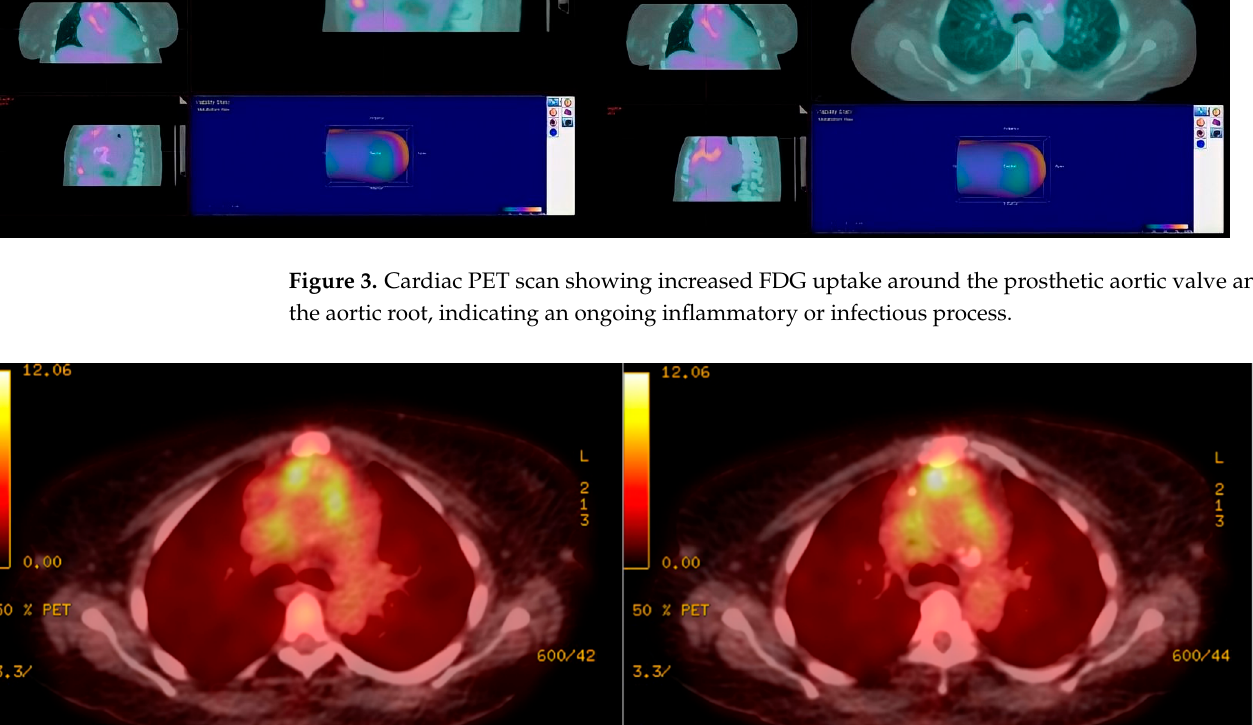
Figure 4. Cardiac CT scan showing increased FDG uptake around the prosthetic aortic valve and the aortic root, indicating an ongoing inflammatory or infectious process.